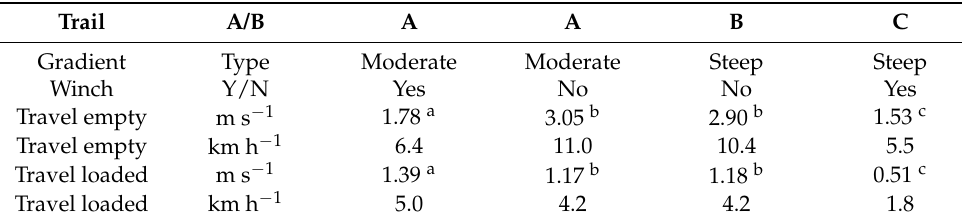
Table 3. Travel speed: mean values recorded under the different treatments. Trail